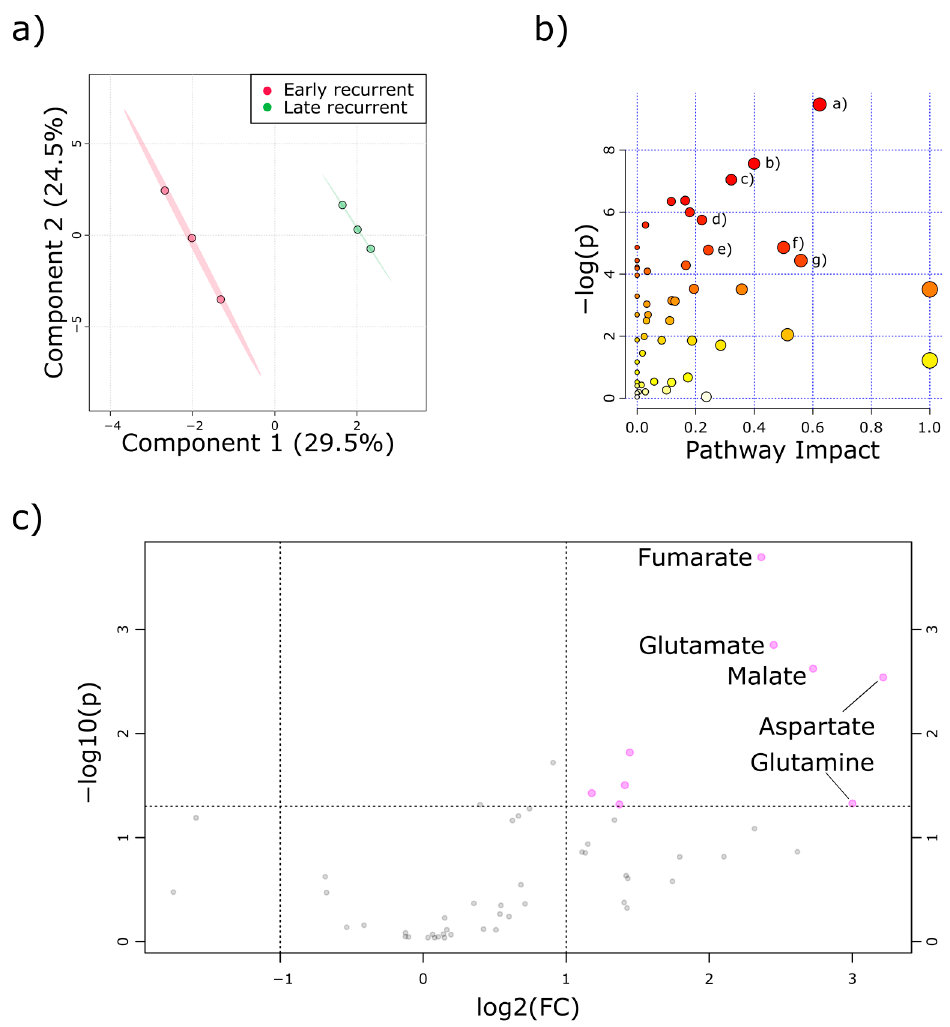
Figure 3. Metabolic profiling revealed tricarboxylic acid cycle (TCA-cycle) intermediates and anaplerotic amino acids were increased in early recurrent PDAC. ( a ) Partial least square discriminant analysis of PDOs derived from early (red) and late (green) recurrent PDAC patient unveiled global metabolic alterations. ( b ) Global pathway analysis revealed different pathways affected in PDOs. Identity of the pathways matching the cut-off values ( − log( p ) > 4 and pathway impact > 0.2) are depicted in table 2. ( c ) Volcano plot analysis of identified metabolites. Early recurrent to late recurrent fold changes are displayed as log2 values. Only top five altered metabolites are labeled. Each data point represents at least three technical replicates of the different PDOs.